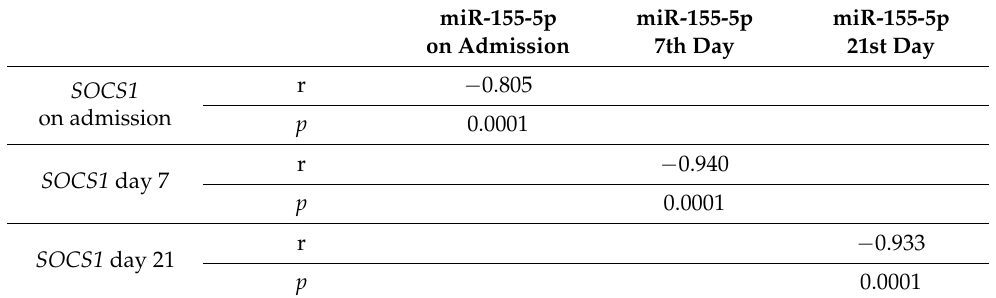
Figure 1. Time-dependent change in expression of miR-155-5p ( a ) and SOCS1 ( b ) in the moderate, severe, and critical group by 2 − ∆∆ Ct -transformed quantification of differential expression. The figure indicates a significant change in the expression of miR-155-5p and SOCS1 between the day of admission to hospital, day 7, and 21. Data are presented as medians. Table 4. Correlations between expression of miR-155-5p and SOCS1 on days of admission, 7, and 21.